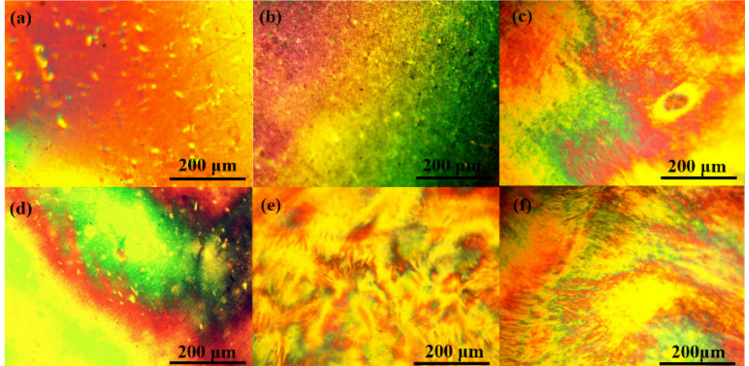
Figure 3. POM images of pure CNC and CNC/DS films with different contents of D-sorbitol: ( a ) 0, ( b ) 2%, ( c ) 3%, ( d ) 4%, ( e ) 5%, and ( f )